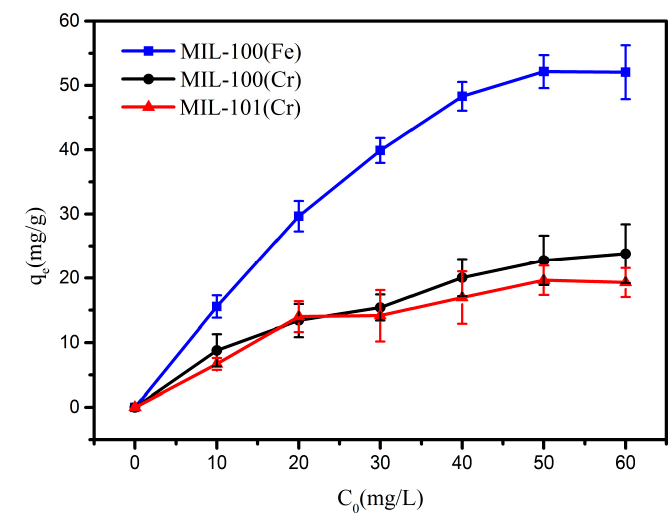
Figure 4. Adsorption isotherms for aniline adsorption on MIL-100(Fe) (blue), MIL-100(Cr) (black) and MIL-101(Cr) (red).